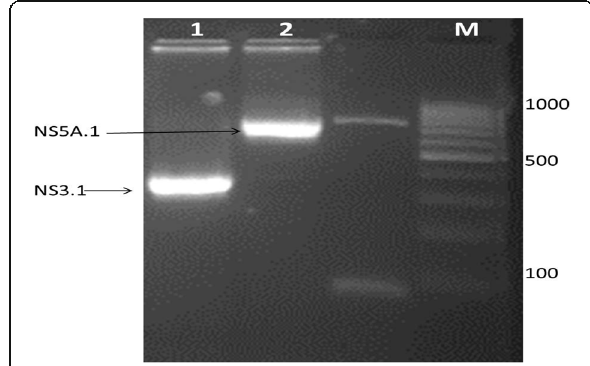
Fig. 3 PCR amplification of antigenic sites (NS3.1 (328 bp) and NS5A.1 (747 bp)) using antigenic restriction site-specific primers.